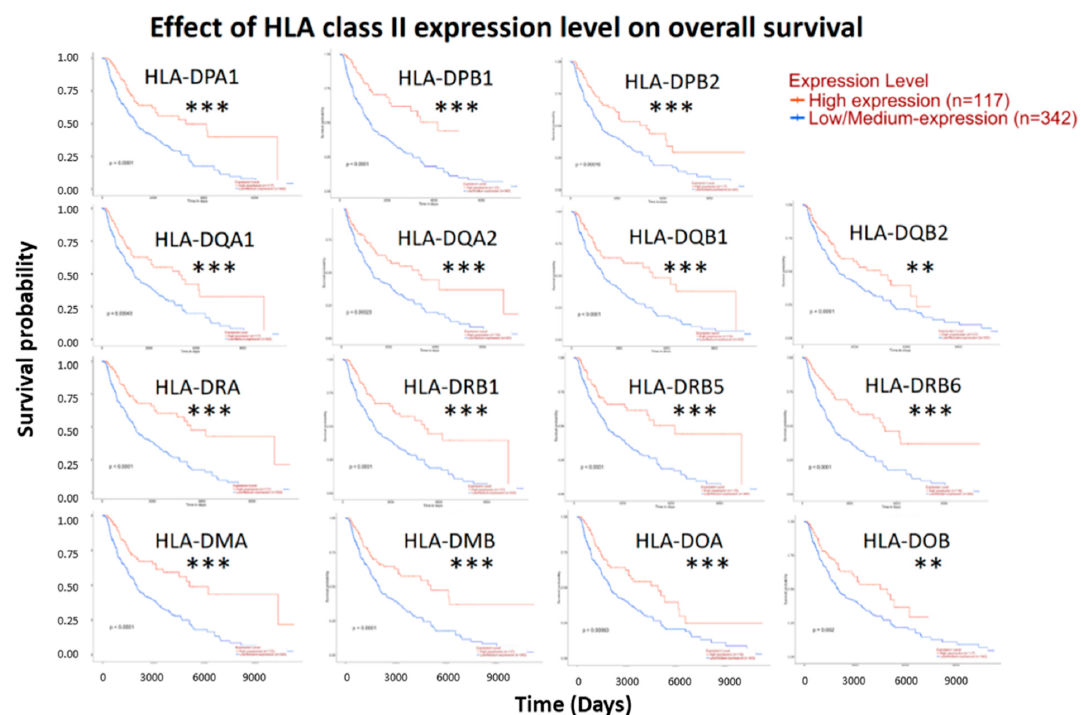
Figure 3. Effect of HLA class II expression level on overall survival. Survival analysis between high